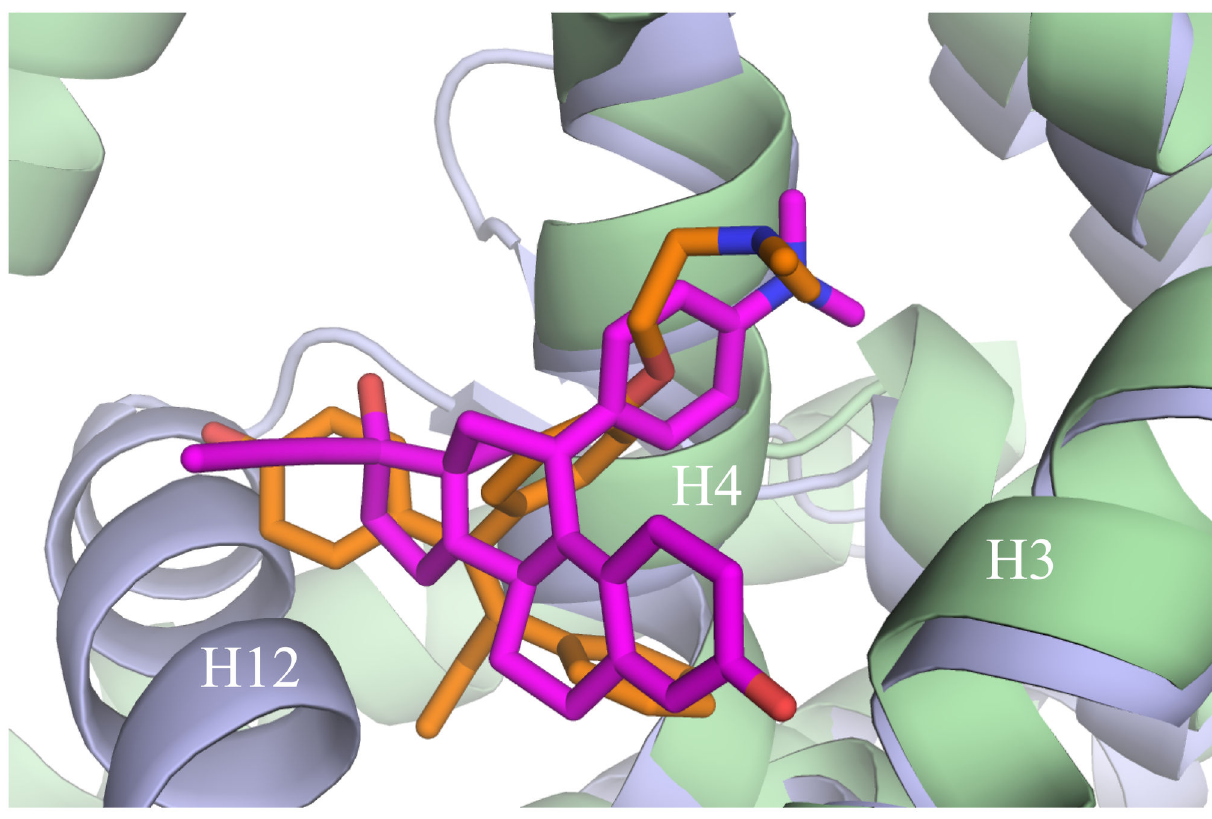
Figure 7. Mifepristone and 4-hydroxytamoxifen show similar binding modes to the steroid receptor coactivator binding cleft. Alignment of the ancSR2–progesterone–mifepristone crystal structure and the ERβ–tamoxifen structure shows both mifepristone and 4-hydroxytamoxifen bound to the coactivator cleft. ancSR2 – slate blue, mifepristone – magenta, ERβ – light green, tamoxifen – orange.